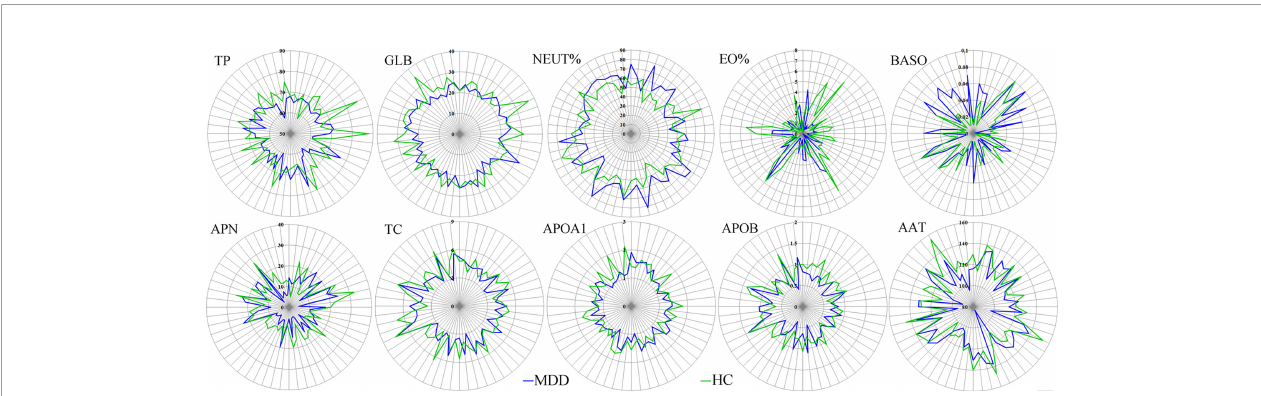
FIGURE 3 | Differential in fl ammation-related factors in MDD patients. The number on each circle represents the levels of in fl ammation-related factors. The each cross-point of blue/green line and semidiameter line represents the levels of in fl ammation-related factors in one sample from MDD/HCs group. MDD, major depressive disorder; HCs, healthy